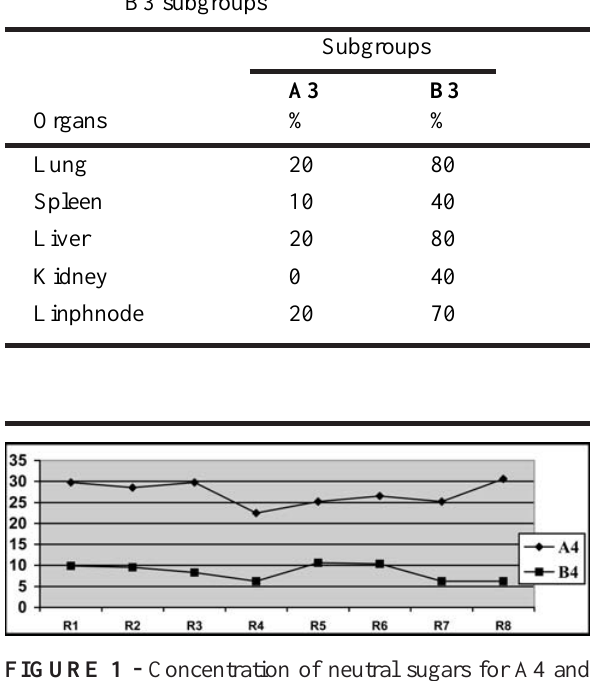
TABLE 2 - Frequency of bacterial recovery from the organs